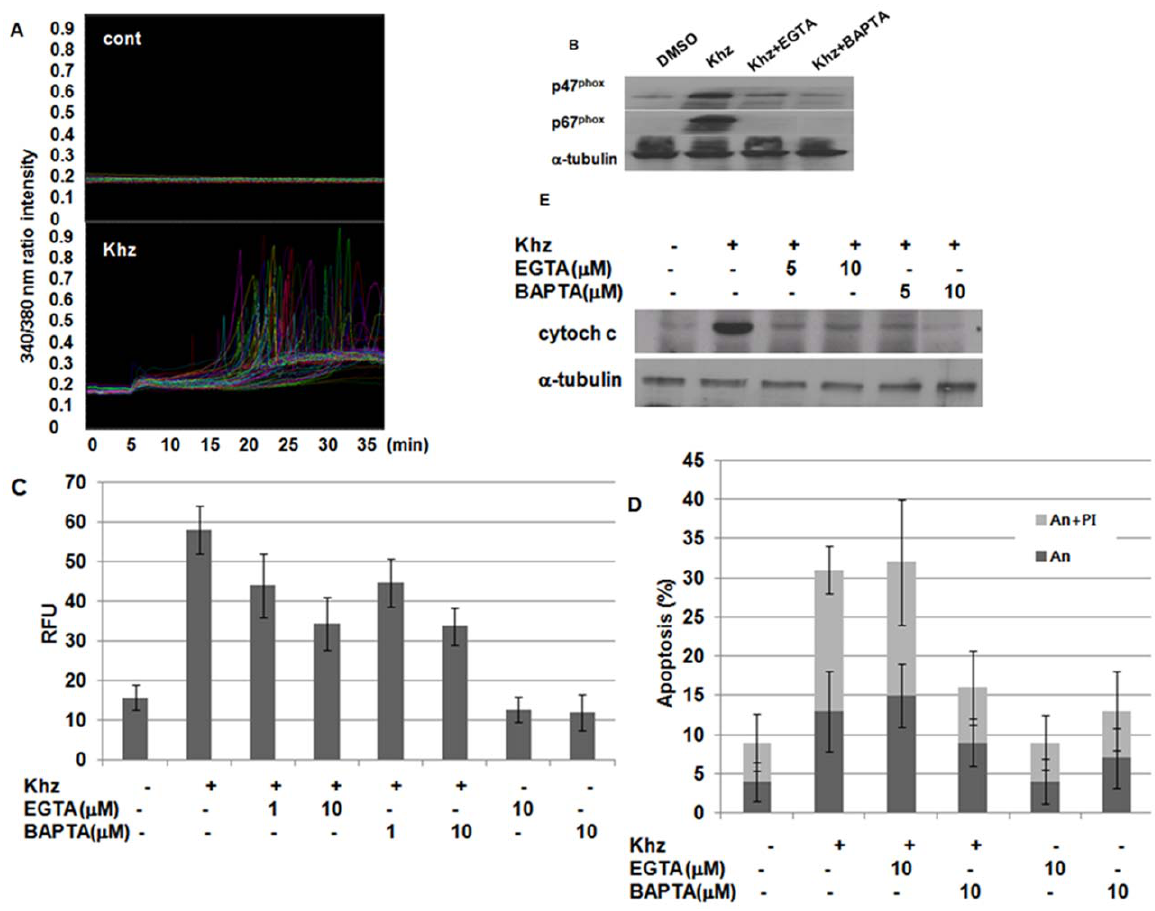
Figure 6. An increase of [Ca 2 + ] i is necessary for Khz-induced ROS generation and apoptosis. (A) HepG2 cells were loaded with fura-2 AM for 30 min and changes in [Ca 2 + ] i after Khz treatment were analyzed by digital imaging microscopy. (B) HepG2 cells were pretreated with EGTA (10 m M) or BAPTA-AM (10 m M) for 30 min, and membrane fractions were prepared for immunoblot analysis 5 min after Khz treatment. (C) Cells were pretreated with EGTA or BAPTA-AM for 30 min and treated with Khz for 30 min. ROS generation in HepG2 cells was then measured using the Amplex Red hydrogen peroxide assay. Data represent mean 6 SD. (D) Cells were pretreated with EGTA or BAPTA-AM for 30 min and treated with Khz for 30 min. (E) Apoptosis was analyzed 1 h after Khz treatment as in Fig.